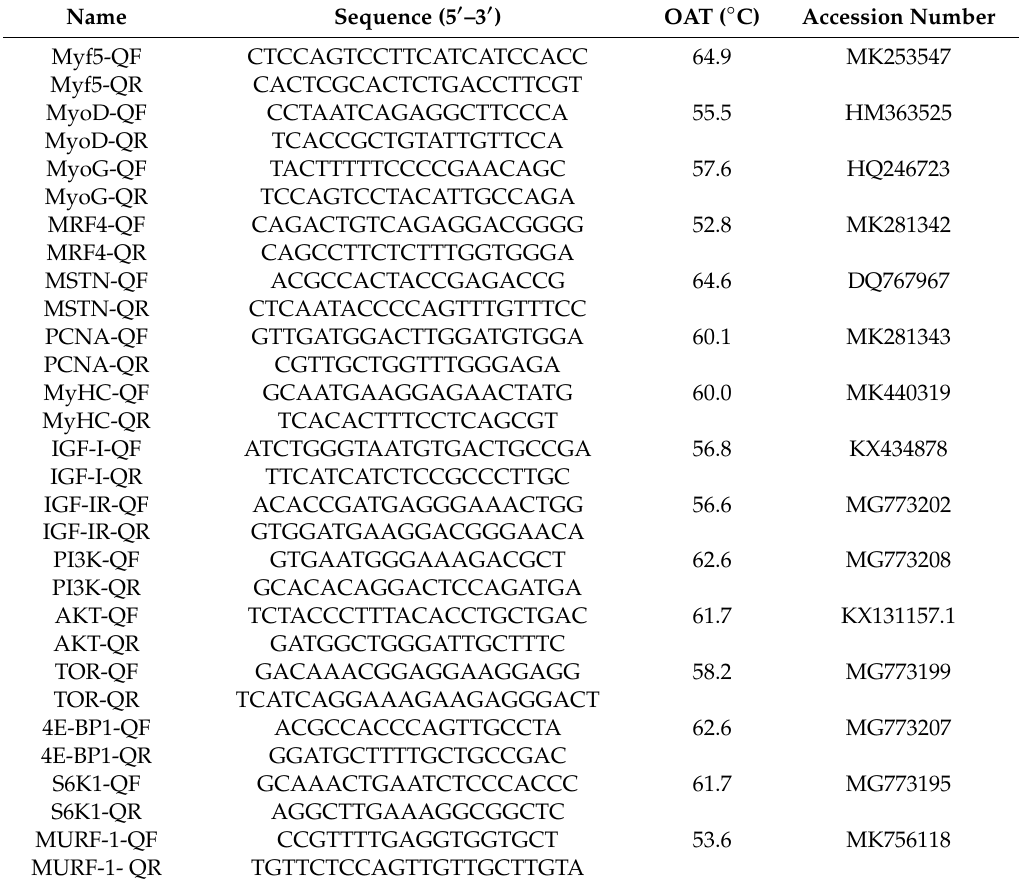
Table 3. Primer sequences and optimal annealing temperatures (OATs) of genes selected for analysis by real-time